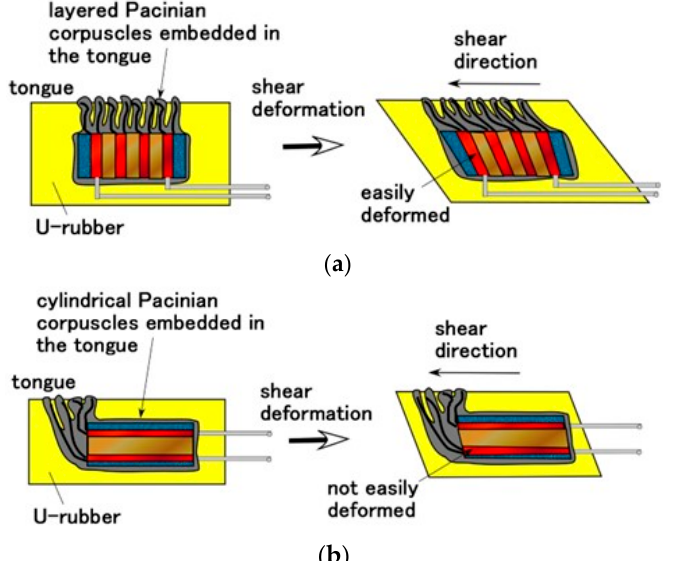
Figure 11. Physical model of results of Figure 10: ( a ) for layered Pacinian corpuscles; ( b ) for cylindrical